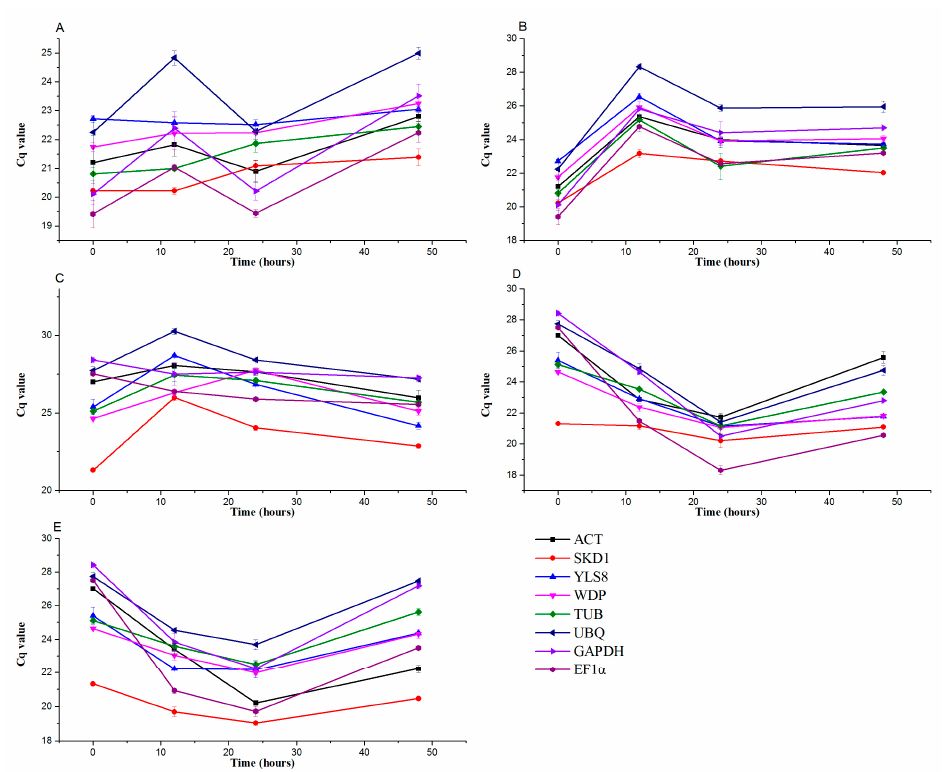
Figure 1. Transcript abundance of the eight reference genes in pear leaves under control conditions and when exposed to different hormones as measured using qPCR. ( A ) Mock, ( B ) SA, ( C ) MeJA, ( D ) ETH, and ( E ) ABA treatment.